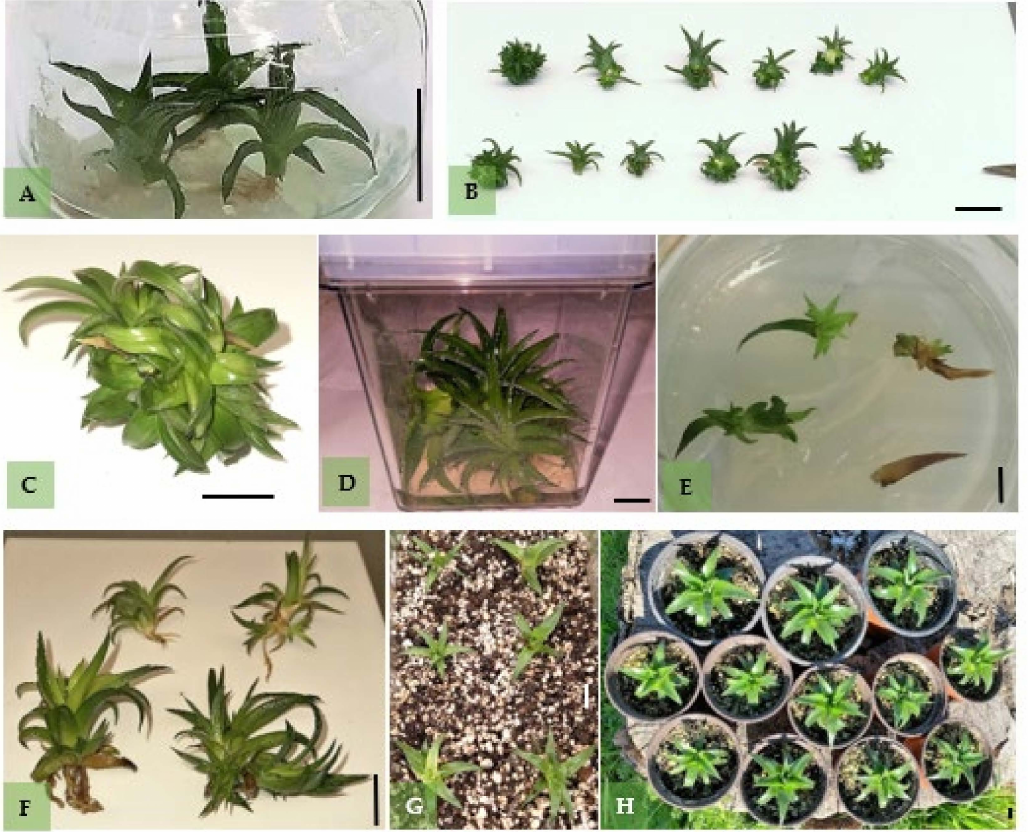
Figure 4. In vitro regeneration of Dyckia brevifolia : ( A ) plantlets growing and root formation during initial transfer of young seedlings after forty days on solid MS-Hf medium; ( B ) first shoots forming on shoot explants after two weeks of culture on solid MS medium containing BA 1 mg L − 1 ; ( C ) multiple shoot formation on a shoot explant after six weeks on a solid MS medium with 1 mg L − 1 BA; ( D ) multiple shoot and spontaneous root formation on a shoot explant after six weeks of culture on a liquid MS medium with 1 mg L − 1 2IP; ( E ) first shoots forming on leaf- explants after two weeks of culture on a solid MS medium containing BA 1 mg L − 1 ; ( F ) multiple shoot and spontaneous root formation on a shoot explant after six weeks of culture on a solid MS medium with 1 mg L − 1 2IP; ( G ) plantlets during ex vitro acclimatisation; ( H ) two-month-old plants showing vigorous growth. Bars represent a length of 1